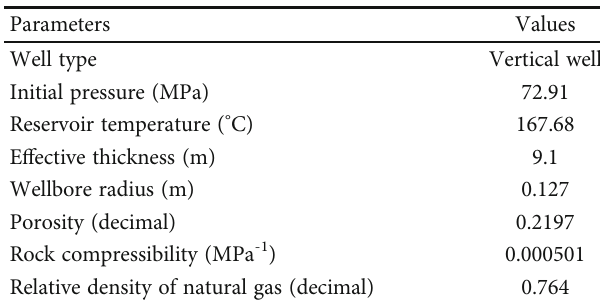
Figure 19: Well test curves of the pressure buildup test under di ff erent storage ratios. Table 1: The basic parameters of gas well test in the deepwater gas reservoir.